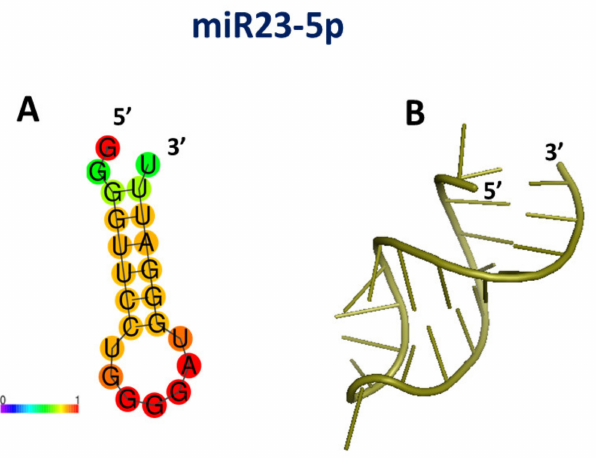
Figure 8. ( A ) Drawing of the best model for the secondary structure of miR23-5p; colors of the spots indicate the corresponding pair-base probability (see the scale at the bottom). ( B ) Graphical representation of the 3D best model for the tertiary structure of miR23-5p, as derived using the secondary structure in ( A ) together with related dot-bracket notation.